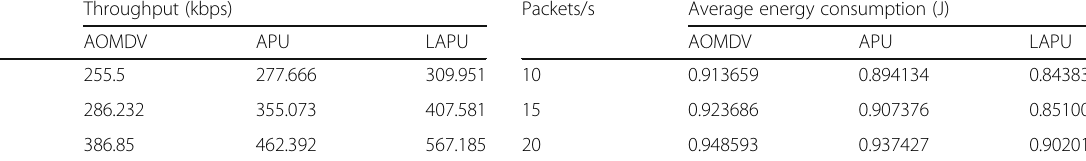
Table 3 Throughput vs. data rate Packets/s